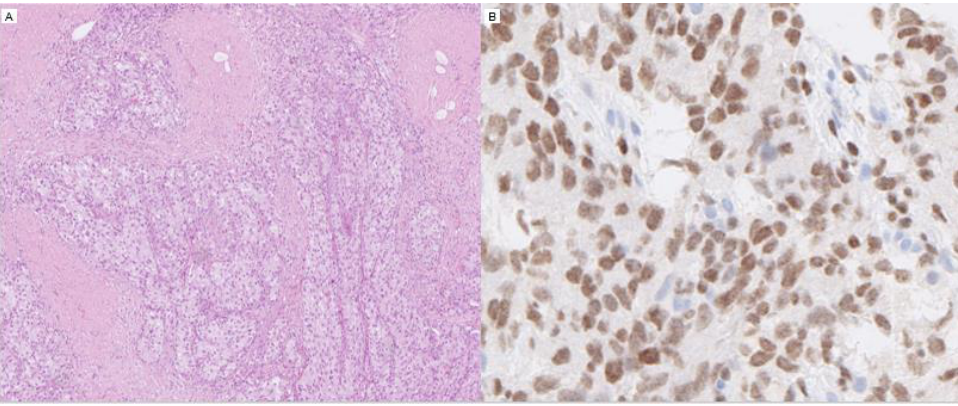
Figure 2. Two histopathological images of urothelial carcinoma, H&E, low magnification ( A ), and GATA3, high magnification ( B ).